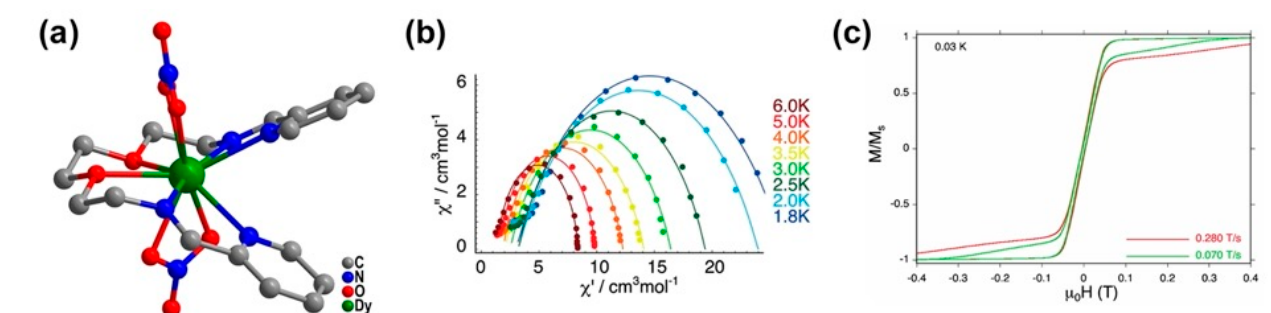
Figure 18. ( a ) Molecular structure of 29 , ( b ) Cole-Cole plots for 29 obtained from the magnetic susceptibility data. The solid lines represent the fit obtained with a generalized Debye model with α = 0.36, 0.35, 0.29, 0.28, 0.26, 0.21, 0.12, and 0.08 sorted by increasing temperatures, and ( c ) Full sweep hysteresis loops for 29 at the indicated sweep rates and temperature. Figures and cations are reproduced with permission from Reference [55] copyright @ American Chemical Society.